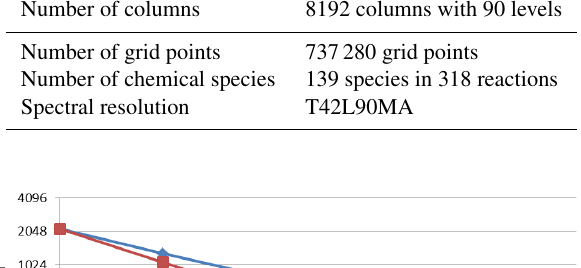
Figure 2. Paraver trace of major processor usage of one time step. Time is along the horizontal and each bar corresponds to a separate CPU core. Blue colour depicts computation; orange corresponds to idle time due to load imbalance. The grid-space transpositions and Fourier and Legendre transformations are shown in magenta.